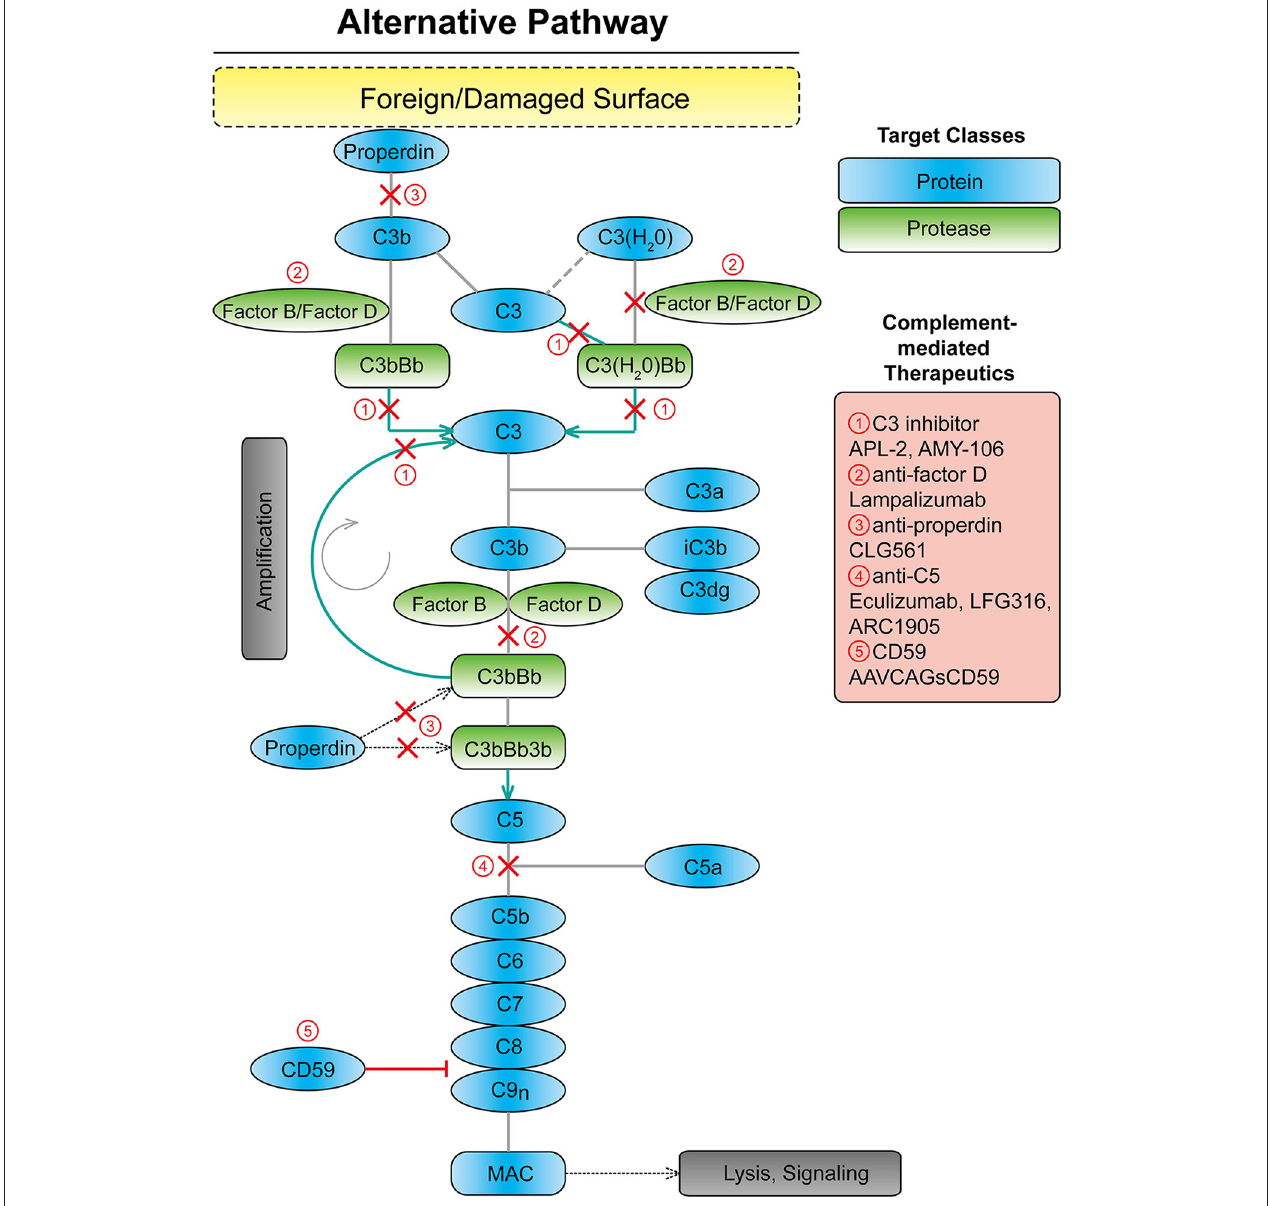
FIGURE 1 | Scheme showing the alternative complement system with targets for complement mediated therapeutics. MAC, membrane attack